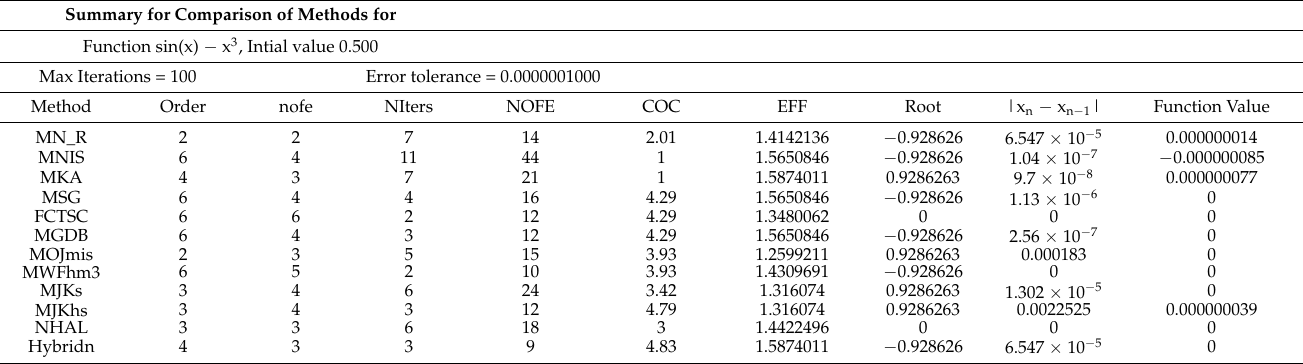
Table 3. All Parameters highlighting NOFE. Comparison of hybrid and all algorithms on all parameters used for the solution for a function.